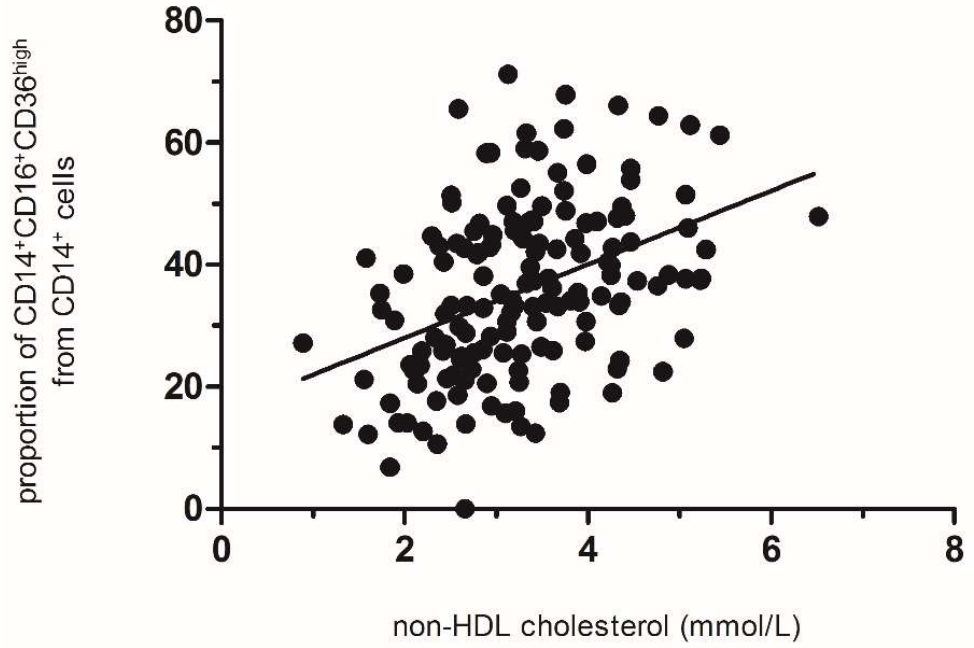
Figure 3. Relation of the proportion of PIMs to non-HDL cholesterol concentration ( n = 154, p < 0.001, r = 0.41). Each dot represents data of one subject (LKD). The line express correlation of the data.